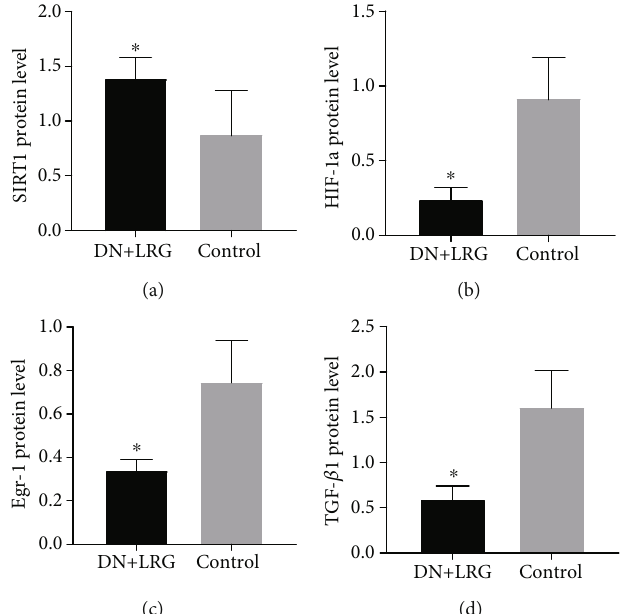
Figure 7: Expression of SIRT1, HIF-1a, Egr-1, and TGF- β 1 proteins in the kidney. Control: diabetic nephropathy group; DN+LRG: diabetic nephropathy+liraglutide group; Egr-1: early growth response-1; HIF-1a: hypoxia-inducible factor-1 alpha; TGF- β 1: transforming growth factor- β 1. ∗ P < 0 : 05 vs. the